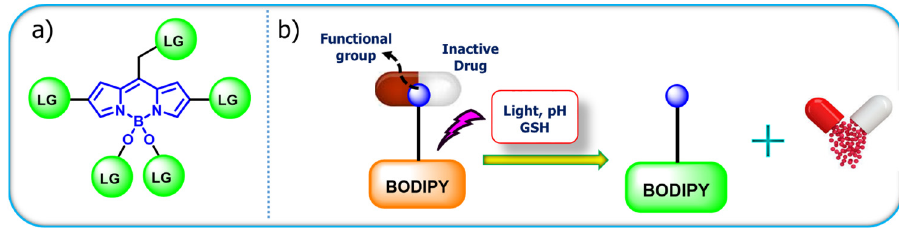
Figure 6. ( a ) Schematic view of BODIPY releases caged leaving group (LG) at a different position. ( b ) Schematic representation of stimuli-responsive drug delivery.